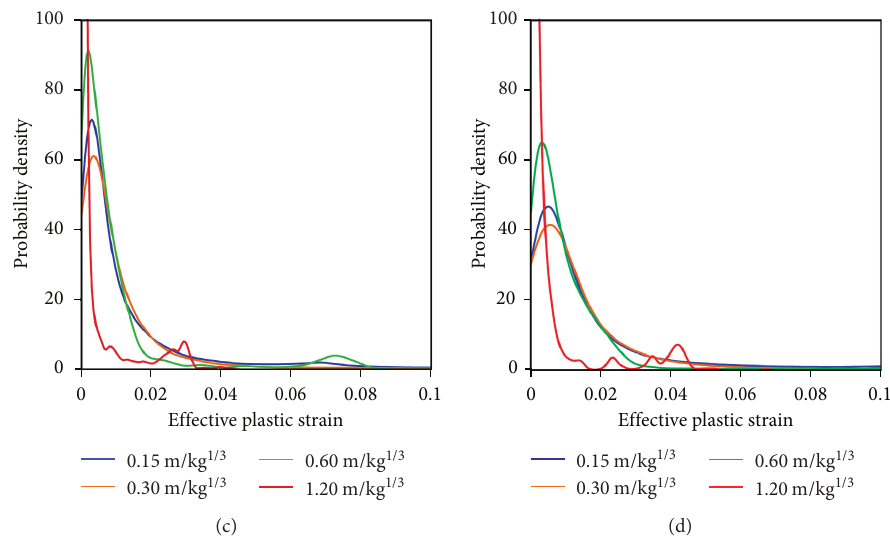
Figure 6: Probability density curves of effective plastic strain distribution in (a) chuanshan limestone, (b) gaolishan sandstone, (c) mineralized limestone, and (d) xixia limestone panels under blast loading with different scaled distances. Table 2: Damage percentage of rock panels under blast loadings with various scaled distances. Rock